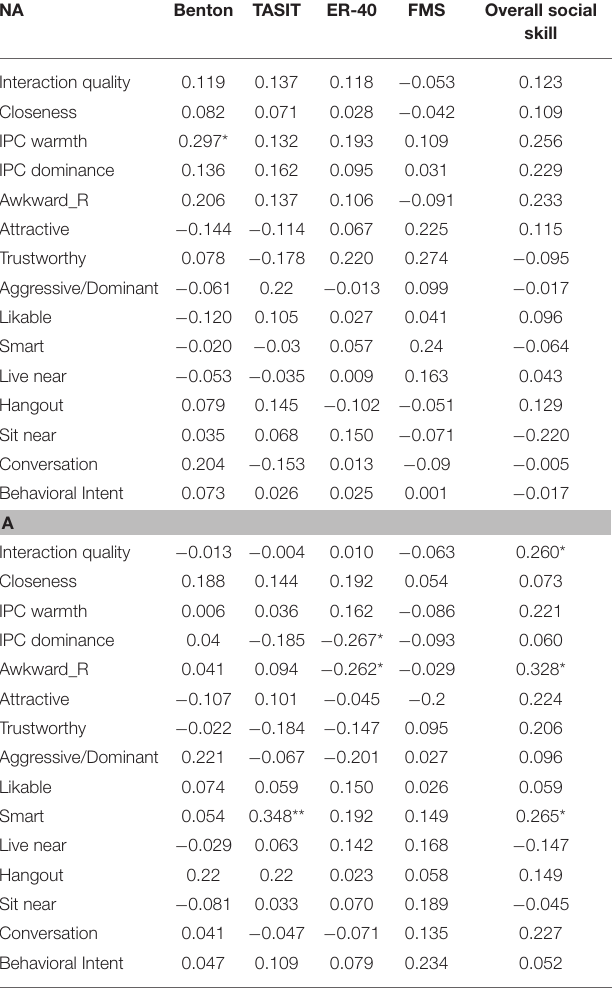
TABLE 6 | Correlations between actor predictors and partner outcomes. NA Benton TASIT ER-40 FMS Overall social